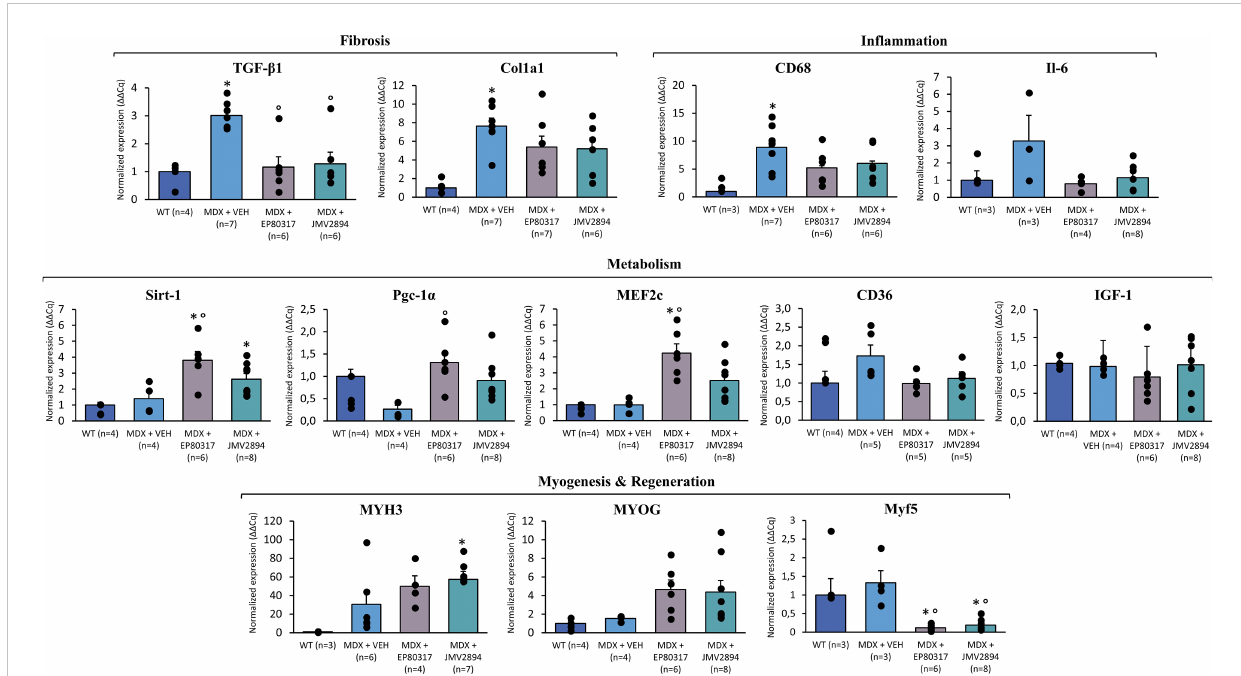
FIGURE 6 Transcriptional levels, measured by qRT-PCR in GC muscle, of genes related to fi brosis ( TGF- b 1; Col1a1 ), in fl ammation ( CD68; IL-6 ), muscle metabolism ( Sirt-1; Pgc-1 a ; MEF2c; CD36; IGF-1 ), myogenesis and regeneration ( MYH3; MYOG; Myf5 ). Values are expressed as mean relative quantity ± SEM from 4 to 10 samples per group, normalized to the mean of housekeeping genes b -actin, HPRT1 . A statistically signi fi cant difference was found among mice groups by one-way ANOVA for TGF- b 1, Col1a1, CD68, Sirt-1, Pgc-1 a , MEF2c, MYH3, Myf5 (F > 19; p < 0.0001). Bonferroni post hoc test for individual differences between groups is as follows: * vs. WT (0.0001 < p < 0.06); ° vs. mdx (0.0001 < p < 0.01). No signi fi cant differences were found for IL-6, MYOG, CD36, IGF-1